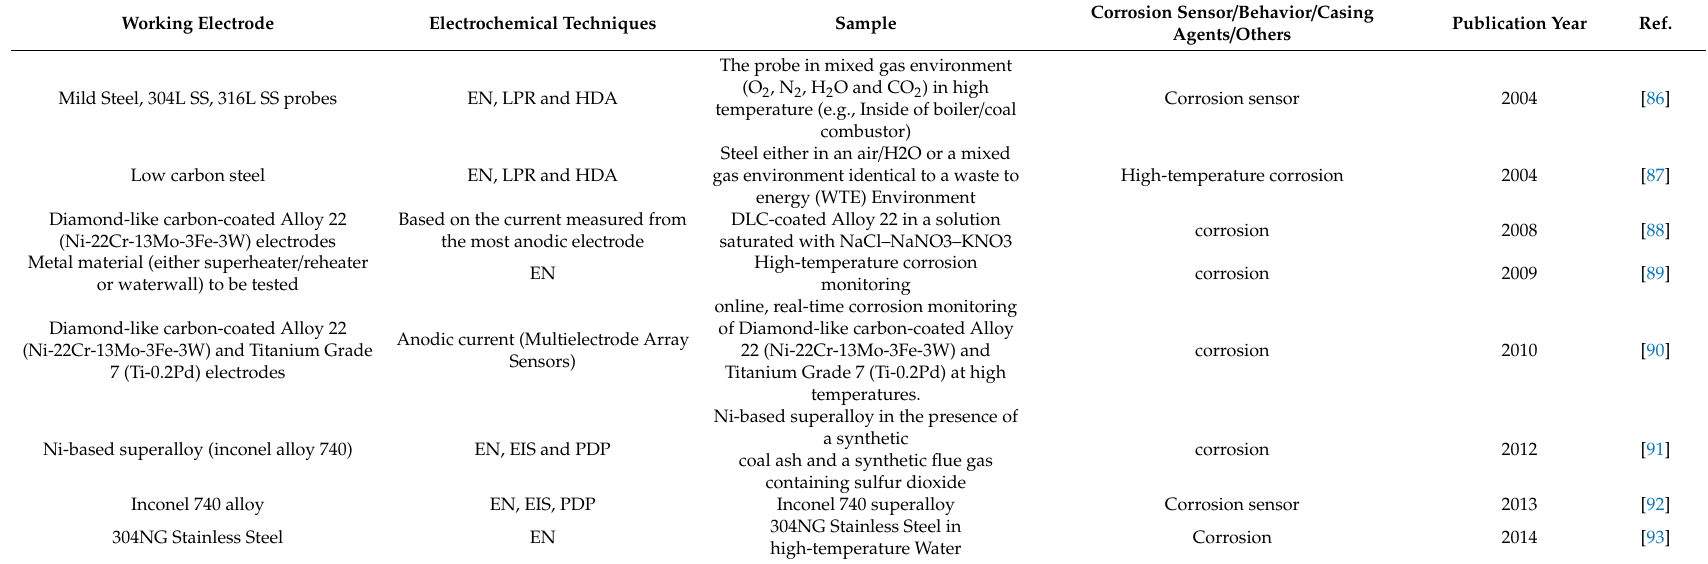
Table 3. Corrosion sensor for monitoring corrosion in hot